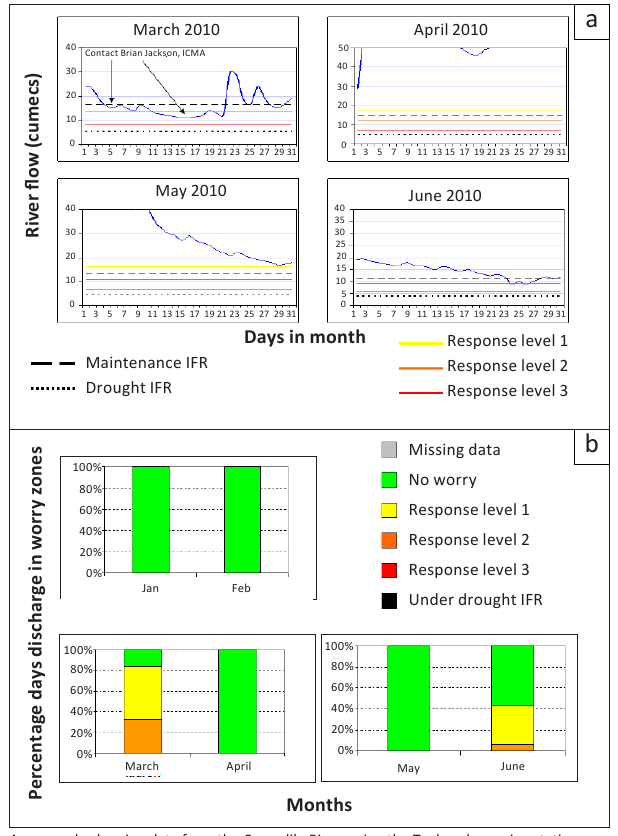
FIGURE 2: The new information format for river flows within the Kruger National Park, indicating Rapid Response (worry levels) zones.